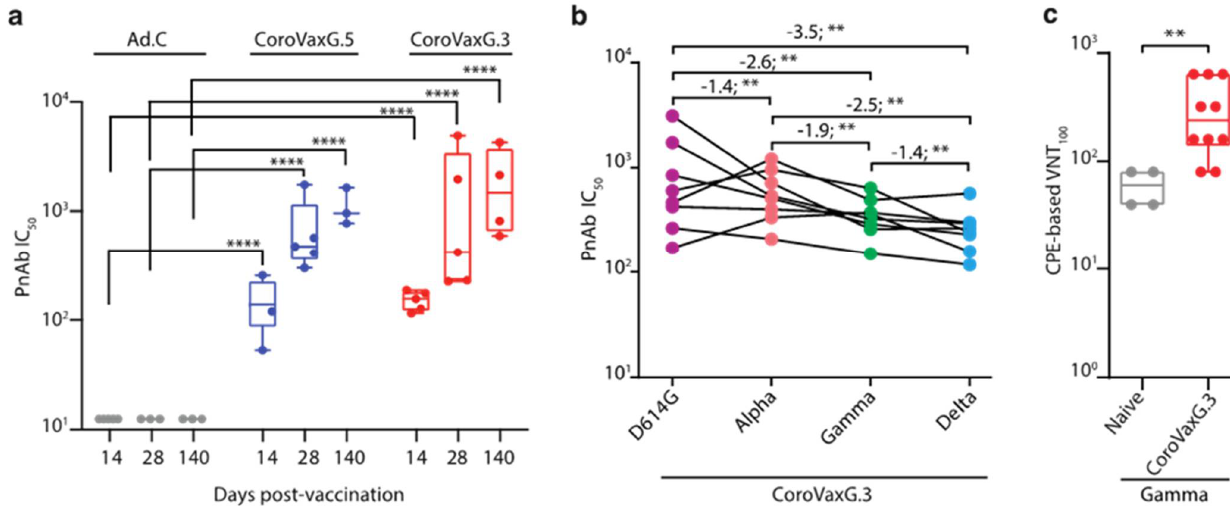
Figure 5. Elicitation of neutralizing antibodies by Ad-vectored vaccines. ( a ) Sera from animals vaccinated with the higher dose were used to measure SARS-CoV2 neutralizing antibodies by a Pseudovirus-Based Neutralization Assay. The box plots show the median, 25th and 75th percentiles, and the whiskers show the range. Comparisons were performed by a Kruskal-Wallis test, followed by Dunn’s multiple comparisons. ( b ) Changes in reciprocal serum neutralization IC50 values of CoroVaxG.3 vaccinated mouse sera (28 days post-vaccination) against SARS-CoV-2 variants of concern. The Fold change in Geometric Mean Titers relative to the WT is written above the p values. The statistical analysis was performed using a Wilcoxon matched-pairs signed rank test. Two-tailed p values are reported. ( c ) Neutralization against the authentic P.1/gamma VOC of CoroVaxG.3-vaccinated mouse sera (28 days post-vaccination). The box plots show the median, 25th and 75th percentiles, and the whiskers show the range. ** p < 0.01, **** p < 0.0001; two-tailed Mann-Whitney U